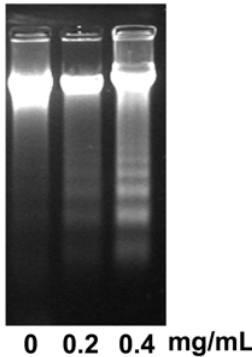
Figure 4. Effect of the essential oil of Cryptomeria japonica on DNA fragmentation in KB cells. KB cells were treated with 0.2 and 0.4 mg/mL of the essential oil for 12 h. Following the treatment, cells were collected for three kinds of experiments assessing apoptosis induction. For DNA fragmentation analysis, intracellular DNA was isolated and analyzed by 2.0% agarose gel